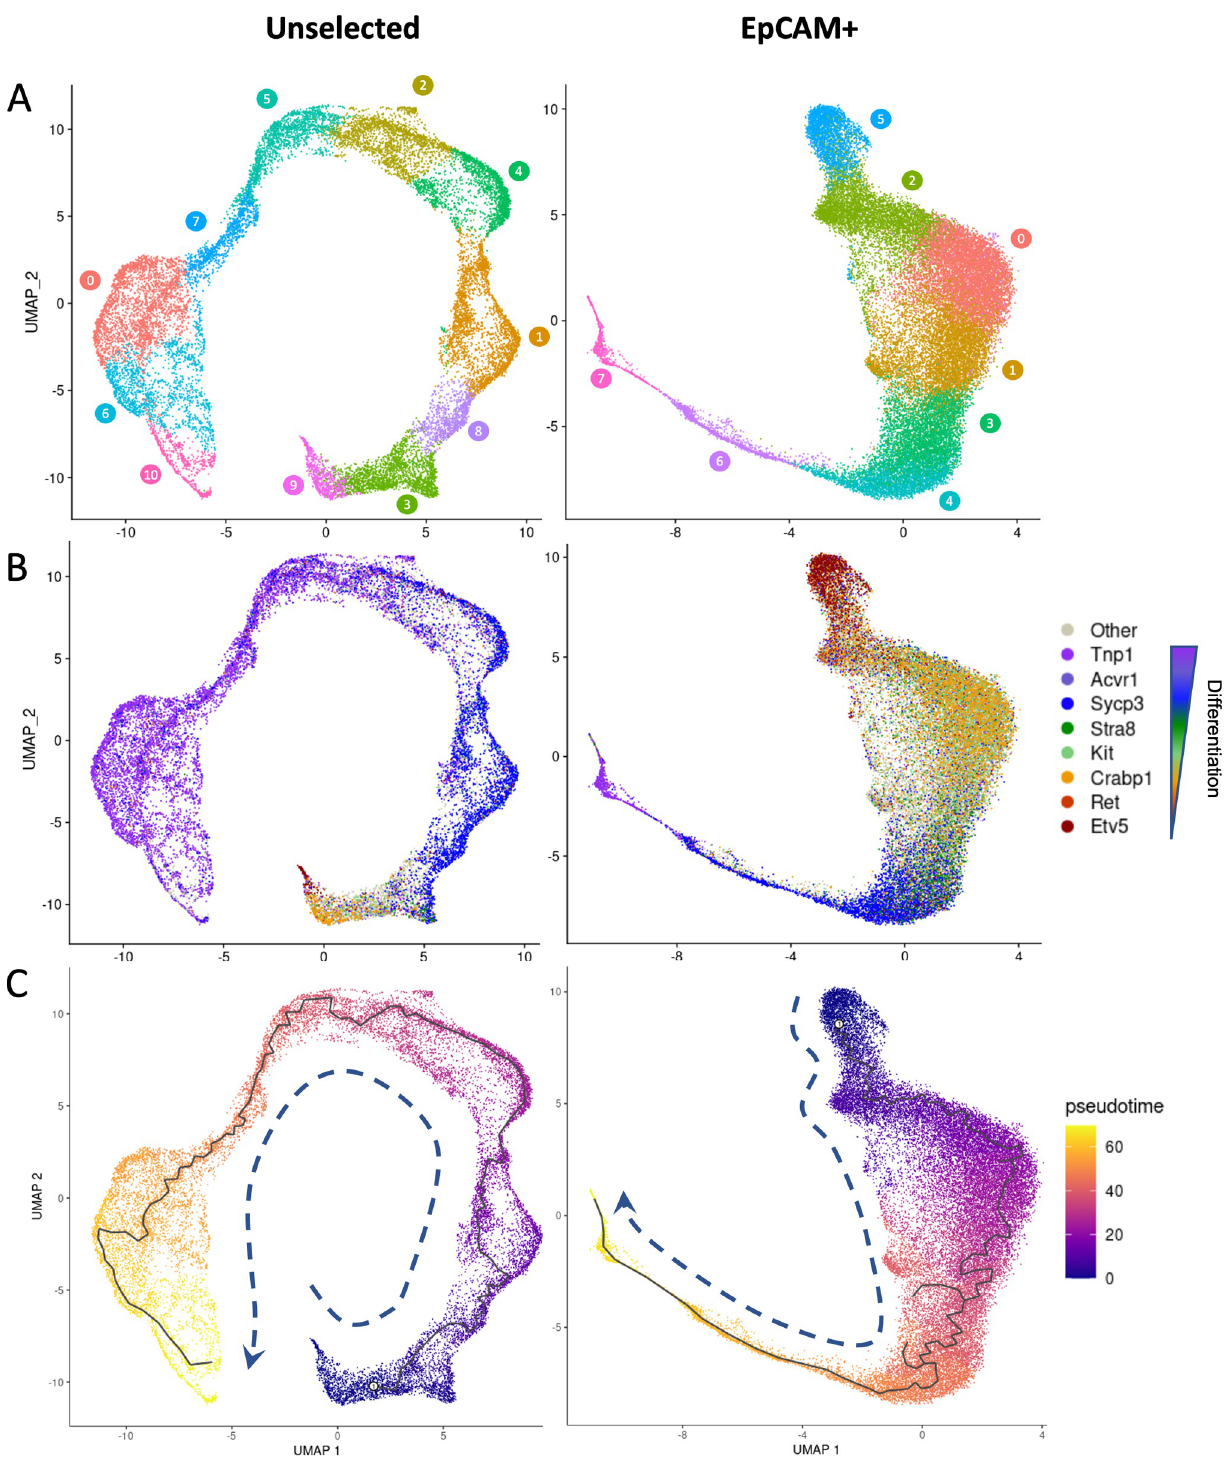
Fig 2. Key germ cell markers delineate transcriptional states in unsupervised clustering. (A) Unsupervised clustering of all germ cells, without selection (left) or selected for the surface marker EpCAM (right). (B) Distribution of select genes (each cell is colored by gene above a threshold of 1 normalized count per million in order listed) in unselected and EpCAM+ germ cells. (C) Pseudotime ordering of unselected and EpCAM+ germ cells. All underlying data deposited in NCBI GEO repository (GSE182438). UMAP, uniform manifold approximation and projection.